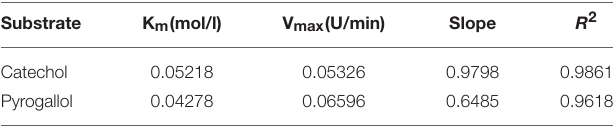
TABLE 1 | Determination of K m and V max for